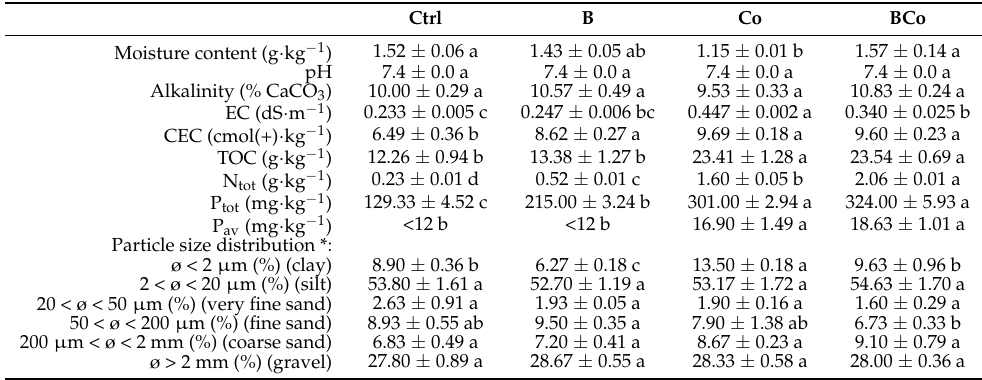
Table 1. Main physicochemical characteristics determined after 12 months of P. euramericana grown on four different substrates (Ctrl, B, Co, and BCo). Different letters indicate significant difference ( p < 0.05) ( n = 3 ± SE). Ctrl: control mix of soil and sand; B: mix of soil and sand + biochar; Co: mix of soil and sand + compost; BCo: mix of soil and sand + biochar + compost. Ctrl